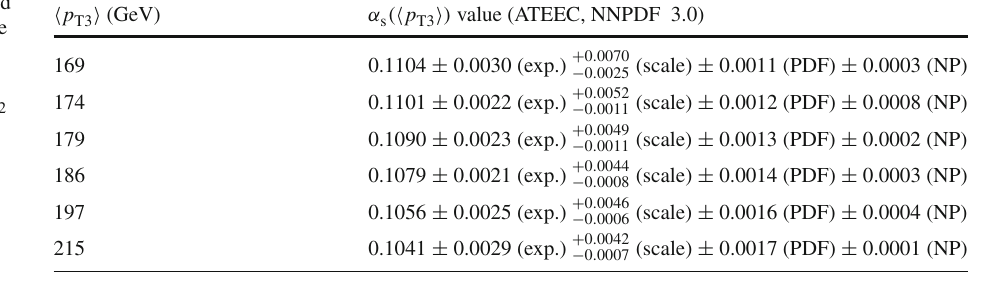
Table 12 Values of α s , obtained from ATEEC fits, evolved to the average value of the average transverse momentum of the three leading jets in each event, (cid:4) ( p + p + p ) (cid:5) / 3 for each T1 T2 T3 bin in H T2